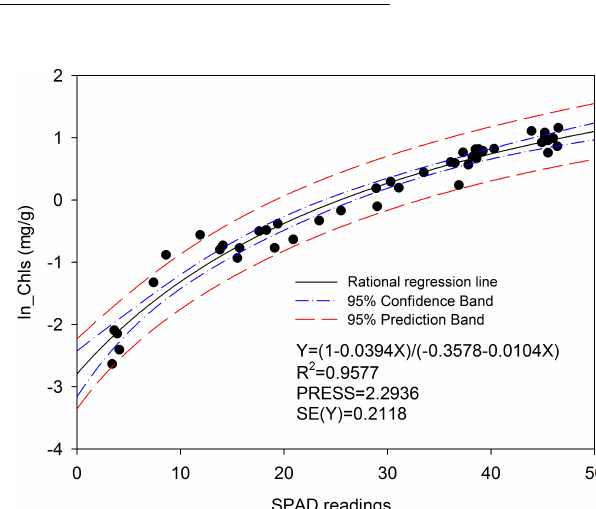
Figure 8. Rational regression model for foliar chlorophyll contents estimation. Number of data points is 45. In the rational model, the independent variable SPAD readings could be used to ex- plain 95.77% ( R 2 ) variation of the dependent variable, lnChls, the natural-logarithm-transformed foliar chlorophyll